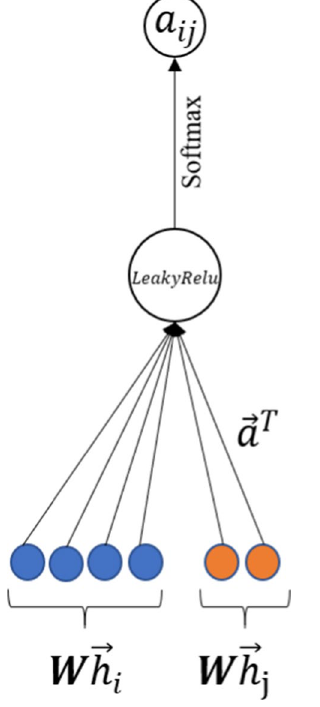
Fig. 3 Single-layer attention score calculation